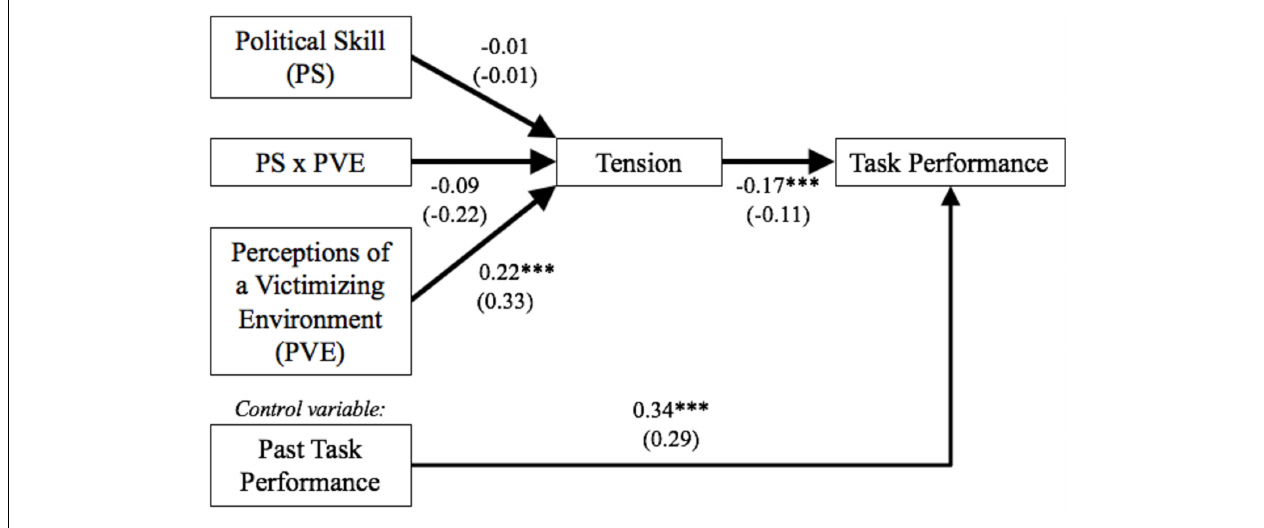
FIGURE 3 | Multi-level path analysis results for Study 2. N = 217, unstandardized parameter estimates are shown in parentheses, multi-level modeling to remove the effects of location-differences on task performance evaluations not shown; ∗∗∗ p < 0.001.